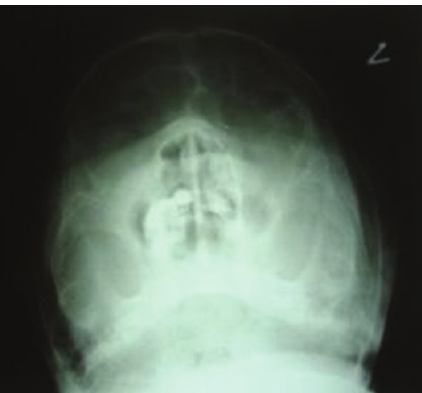
Figure 3: Paranasal sinus view depicting radiolucency involving maxillary anterior region.